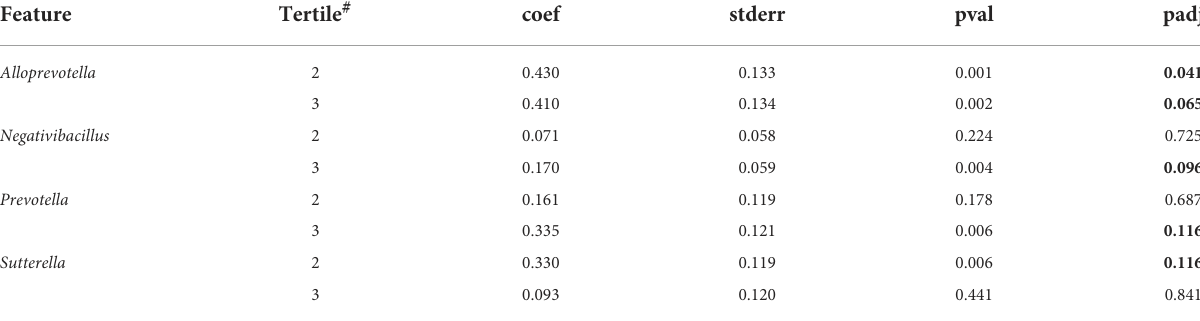
TABLE 3 Results of the association analysis performed with MaAsLin2 between taxonomic feature counts at genus level and tertiles of percentage in UPF energy intake. Feature Tertile #